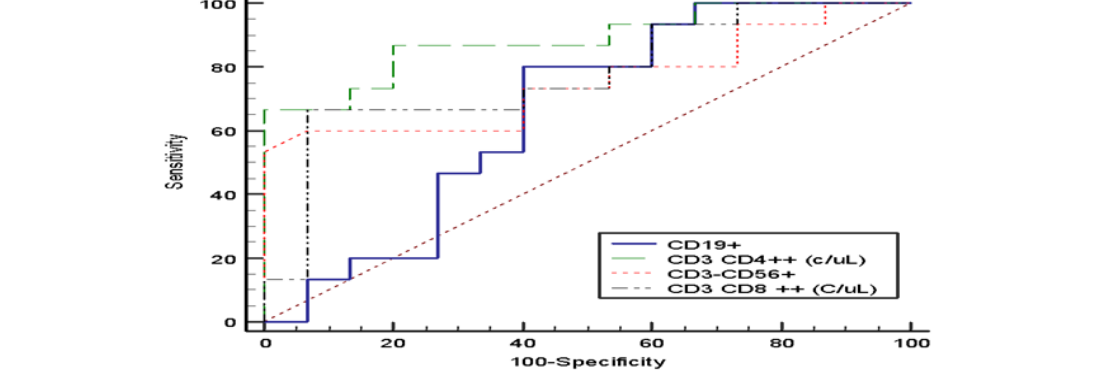
Figure 3. Comparison of ROC curves for different lymphocytic subsets in differentiation and prediction of COVID-19 severity among patients.